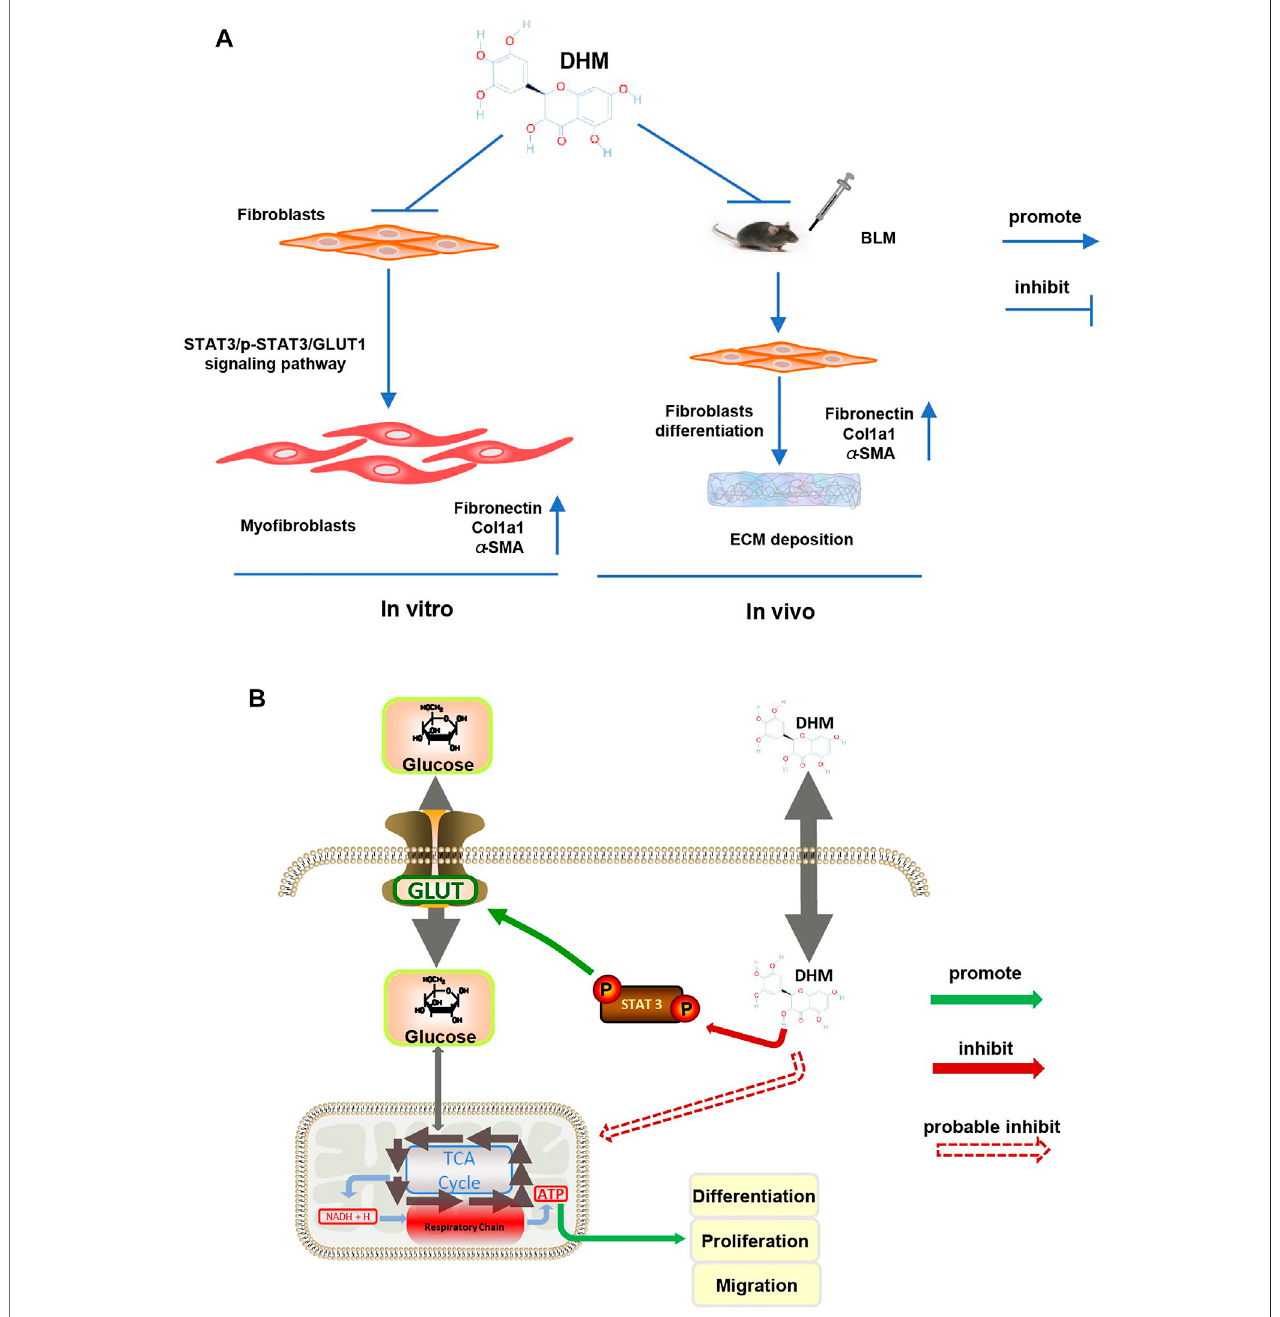
FIGURE8| MechanismofDHMonpulmonary fi brosis. (A) Schematicpresentationofthemechanisminpulmonary fi brosisaffectedbyDHM:TGF- β 1couldinduce fi broblasts to differentiate into myo fi broblasts and overexpress fi bronectin, Col1a1, and α -SMA in vitro , while DHM could suppress this differentiation progress by inhibiting the STAT3/p-STAT3/Glut1 signaling pathway; DHM could also alleviate pulmonary fi brosis induced by BLM via suppressing the differentiation of fi broblasts in the mouse model. (B) Intracellular signaling pathway of DHM: phosphorylation of STAT3 could promote the expression of GLUT1 and enhance the production of ATP, which eventually lead to the differentiation, proliferation, and migration of fi broblasts; DHM could regulate these functions by inhibiting the phosphorylation of STAT3. DHM might also regulate the respiratory chain directly and lead to the suppression of differentiation, proliferation, and migration of fi broblasts.